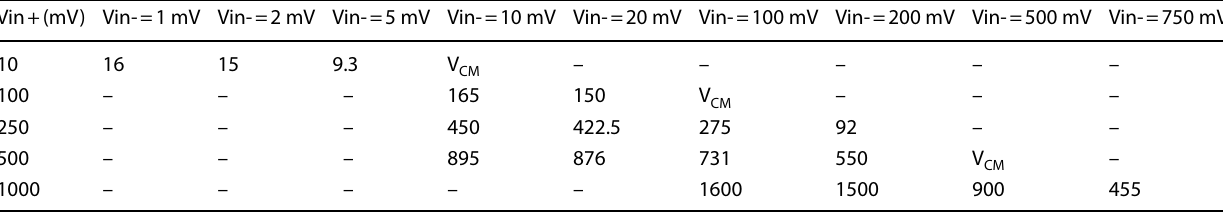
Table 3 Peak output voltages for a range of differential input voltages